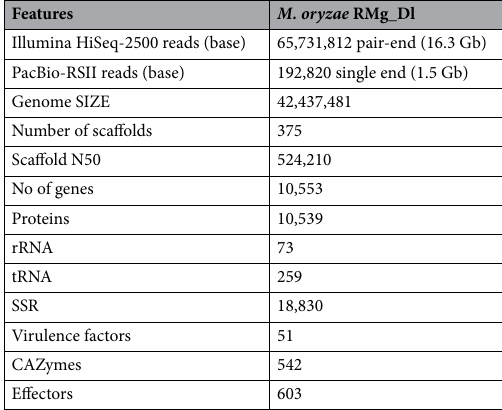
Table 1. Comparative statistics of the assembled whole genome of M. oryzae